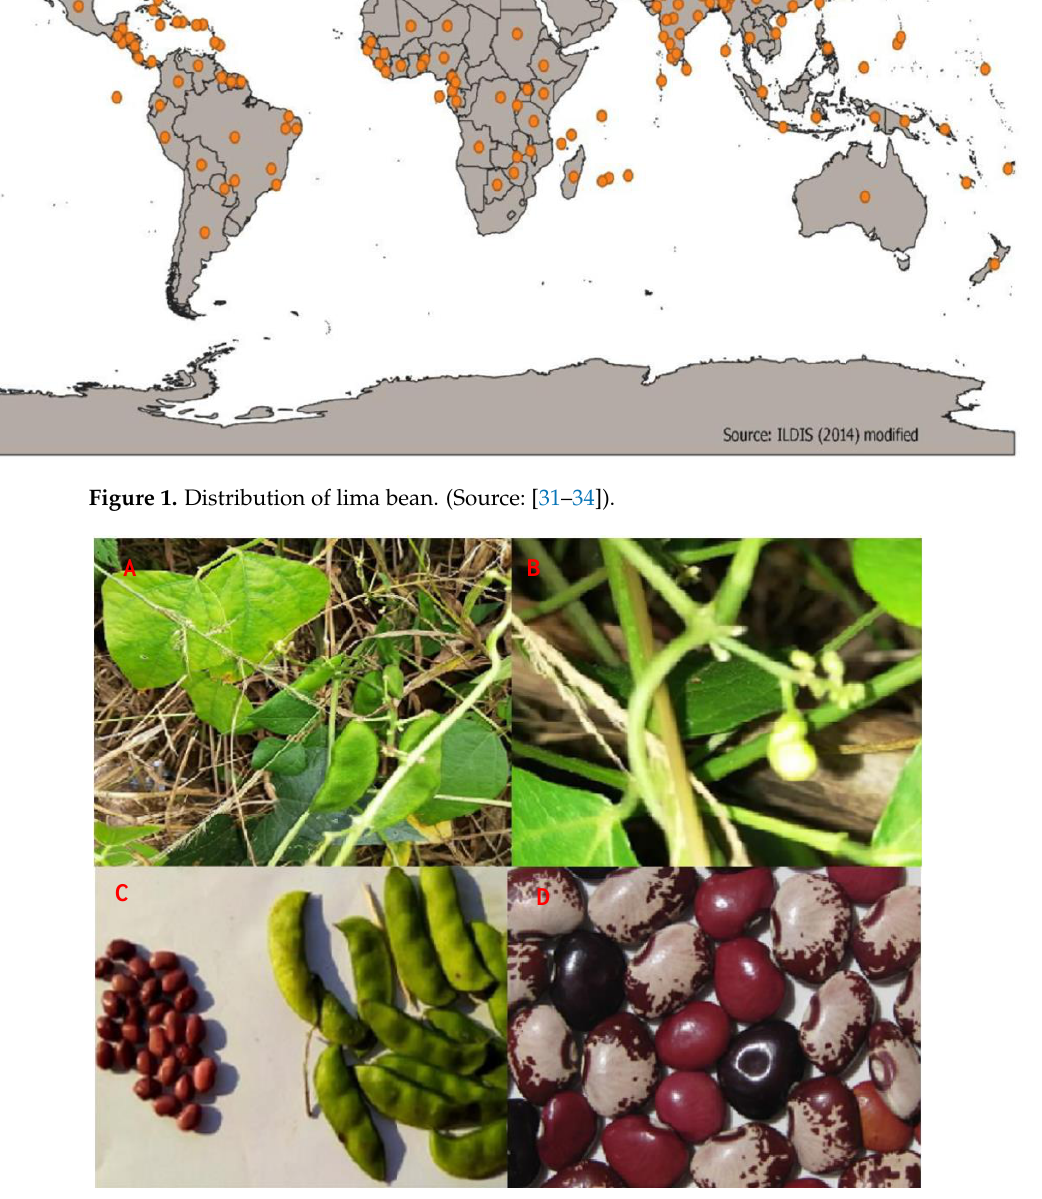
Figure 2. ( A ) Lima bean pods and leaves ( B ) Flower ( C ) Lima bean seeds and pods [10] ( D ) Lima bean seeds variability [35].